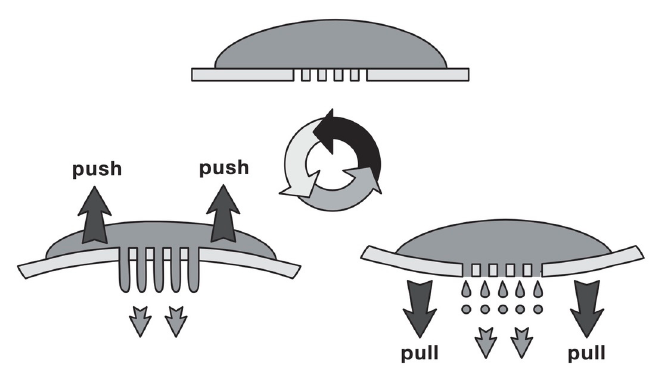
Figure 3. Schematic representation of the spray mesh for the generation of droplets in the nano spray dryer. Buchi, Labortechnik AG [28].